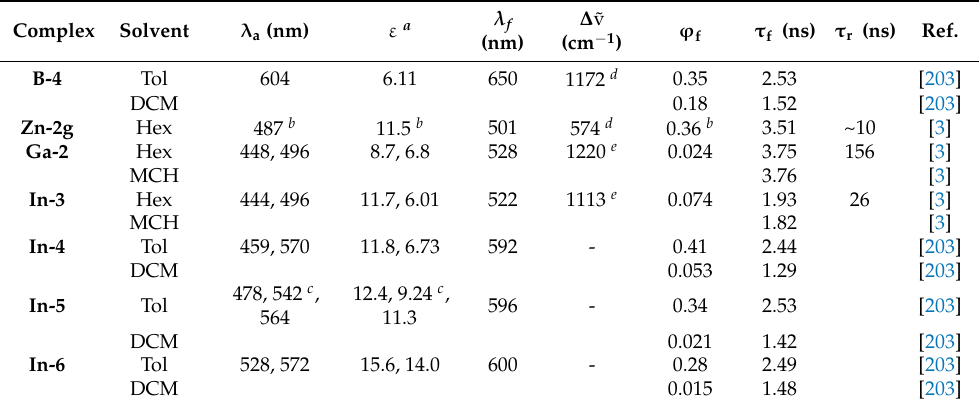
Table A5. Photophysical properties of several tris(dipyrrinato)Ga(III) and -In(III) complexes and reference compounds B-4 and Zn-2g .